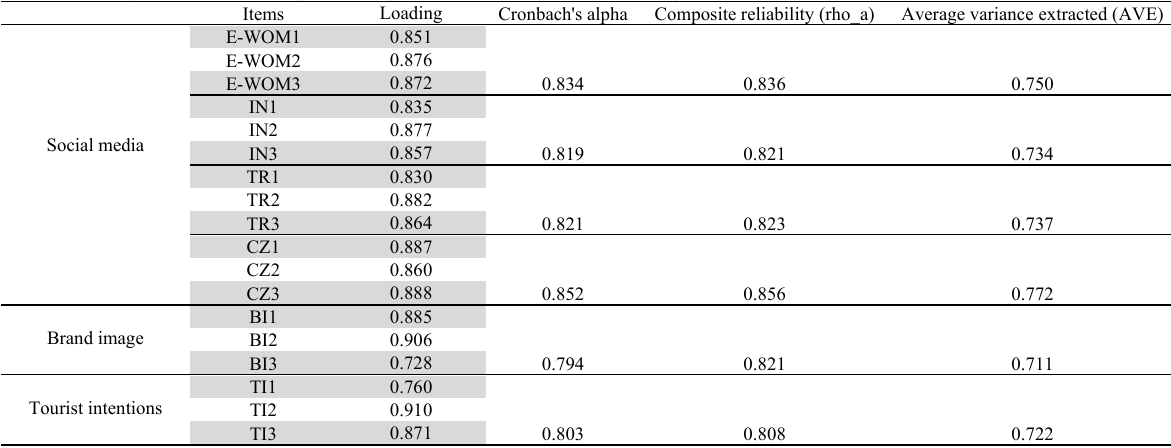
Factor loadings, Cronbach’s Alpha, Composite Reliability, and Convergent Validity